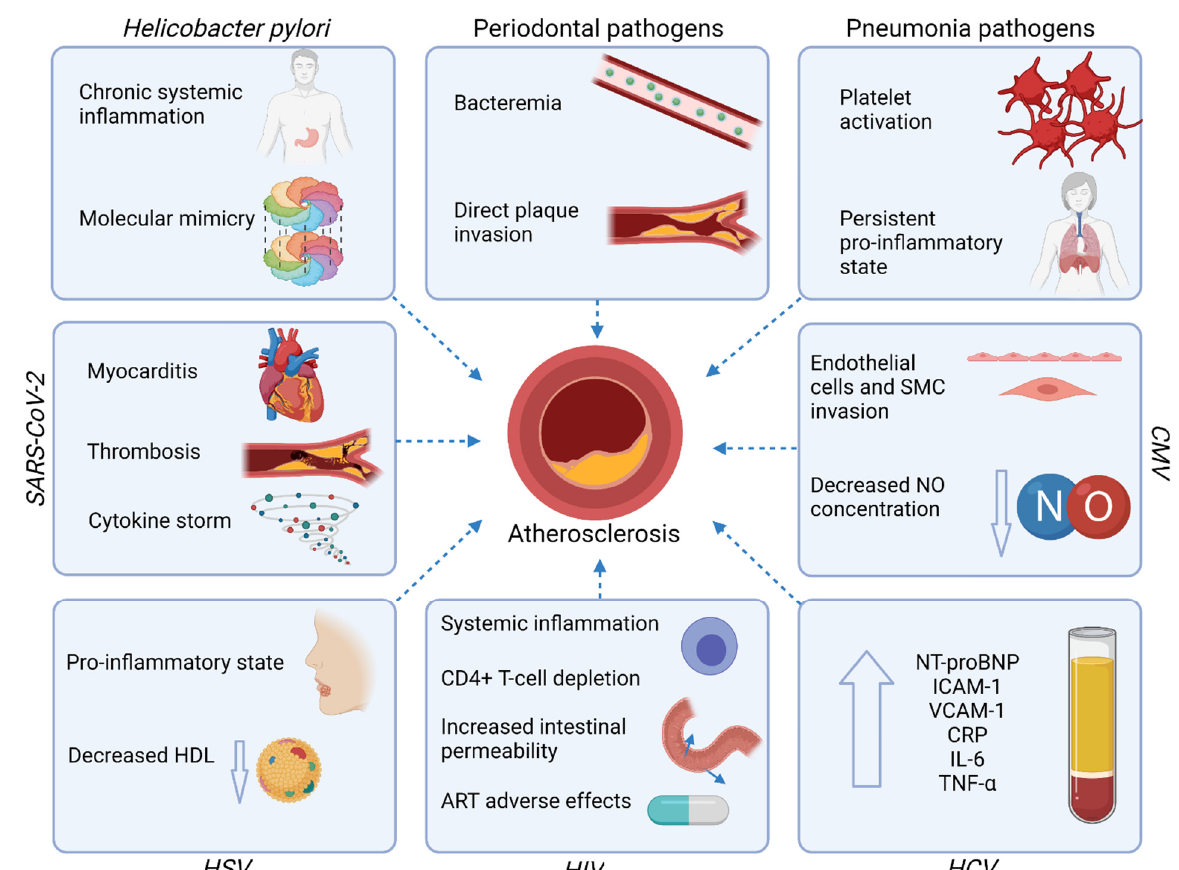
Figure 2. Mechanisms underlying the increased risk of ASCVD in course of infections. Abbreviations: ART—antiretroviral therapy; CMV—Cytomegalovirus; CRP—C-reactive protein; HCV—Hepatitis-C virus; HDL—high-density lipoprotein; HIV—Human immunodeficiency virus; HSV—Herpes simplex virus; ICAM-1—Intercellular adhesion molecule-1; IL— interleukin; NO—nitric oxide; NT-proBNP—N-terminal pro-B-type natriuretic peptide; SARS-CoV-2—Severe acute respiratory syndrome coronavirus-2; SMC—Smooth muscle cells; TNF- α —tumor necrosis factor-alpha; VCAM-1—Vascular cell adhesion protein 1. Created with Biorender.com, licensed version.